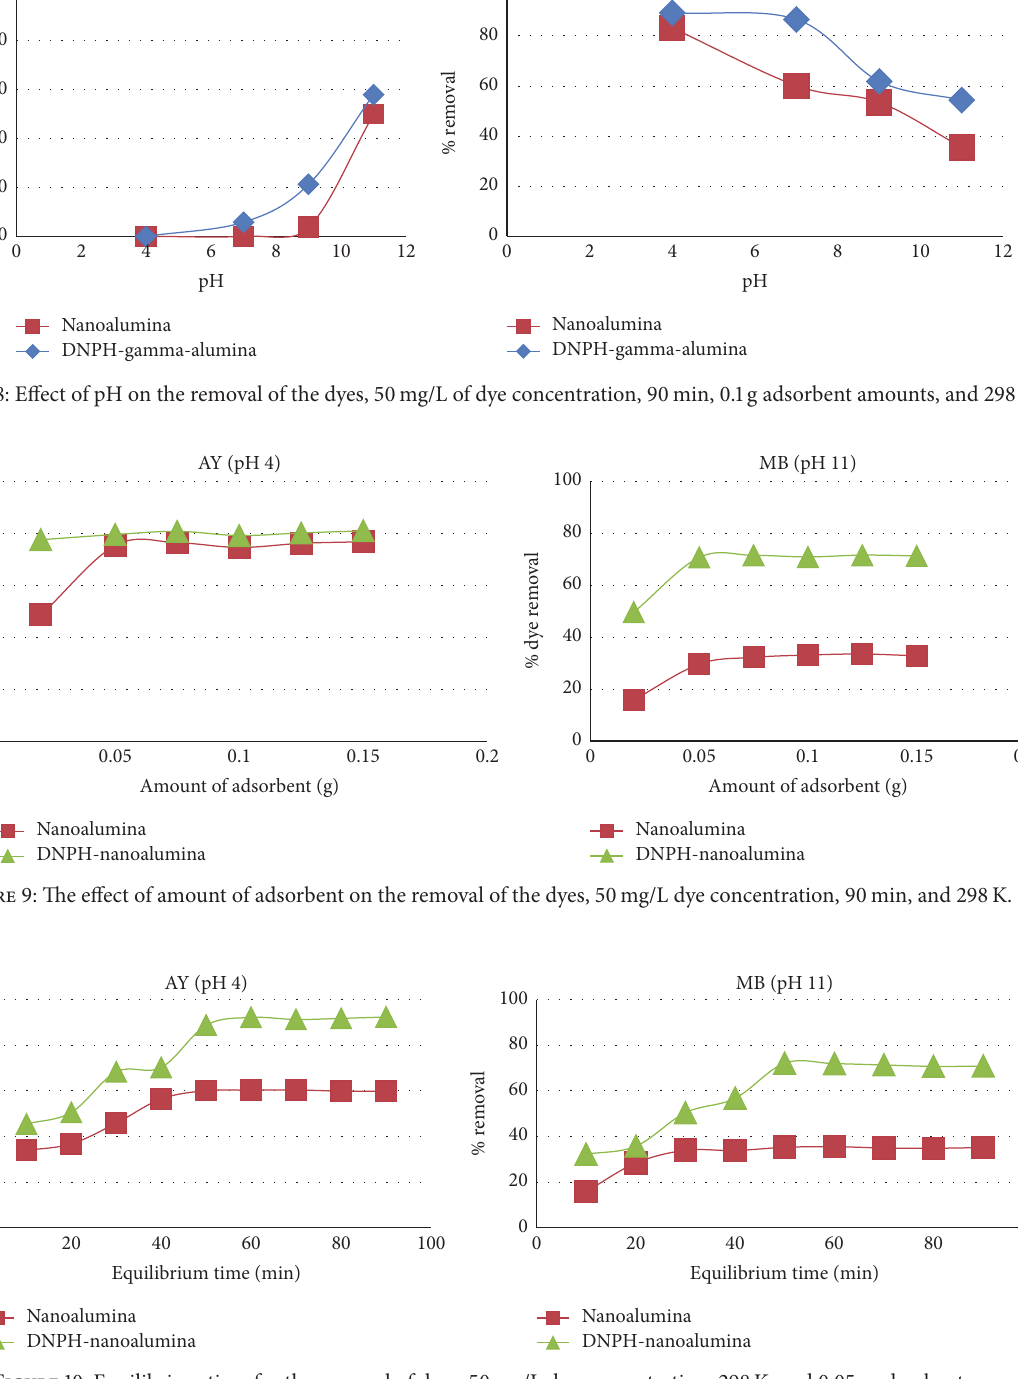
preference of the Langmuir isotherm with a maximum adsorption capacity of 32.8